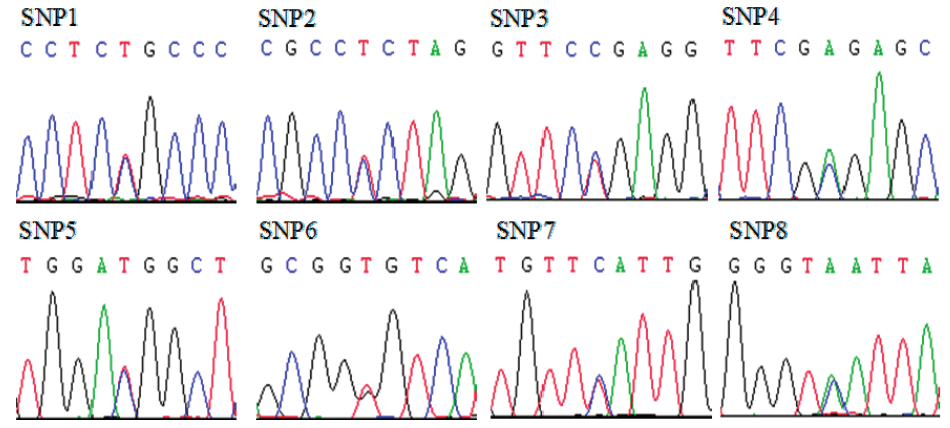
Figure 3. The sequencing maps of the eight detected single nucleotide polymorphisms (SNPs) within the bovine SMO gene. SNP1: g.22935C>T; SNP2: g.22939T>C; SNP3: g.23232C>T; SNP4: g.23283C>A; SNP5: g.23329C>T; SNP6: g.23458T>G; SNP7: g.23633T>C; SNP8: